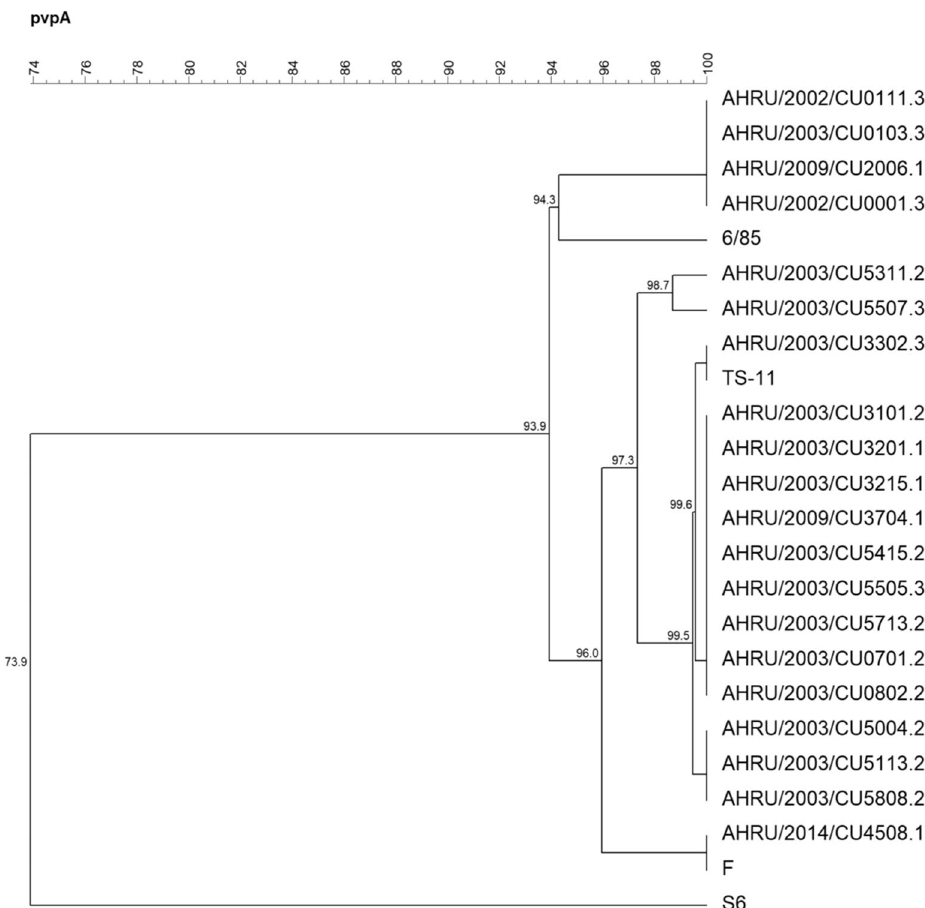
Figure 3. A phylogenetic tree of Thai MG and reference strains based on the alignment of the partial pvpA gene was constructed with the unweighted pair group method with arithmetic mean (UPGMA) using Bionumeric version 7.6